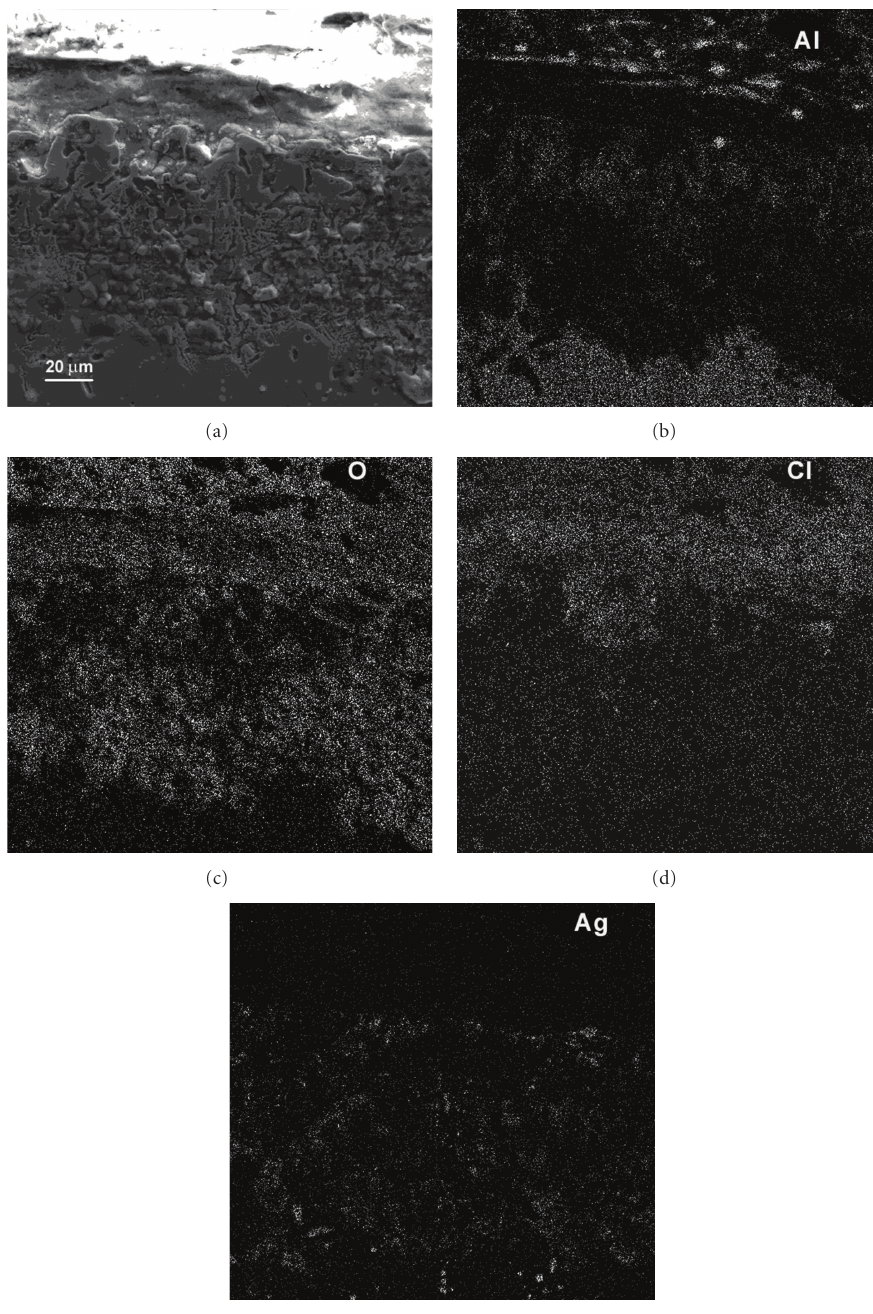
Figure 10: Microphotograph of Fe40Al + 2.5Ag corroded in the KCl + ZnCl 2 mixture at 670 ◦ C together with X-ray mappings of Al, Cl, O, and